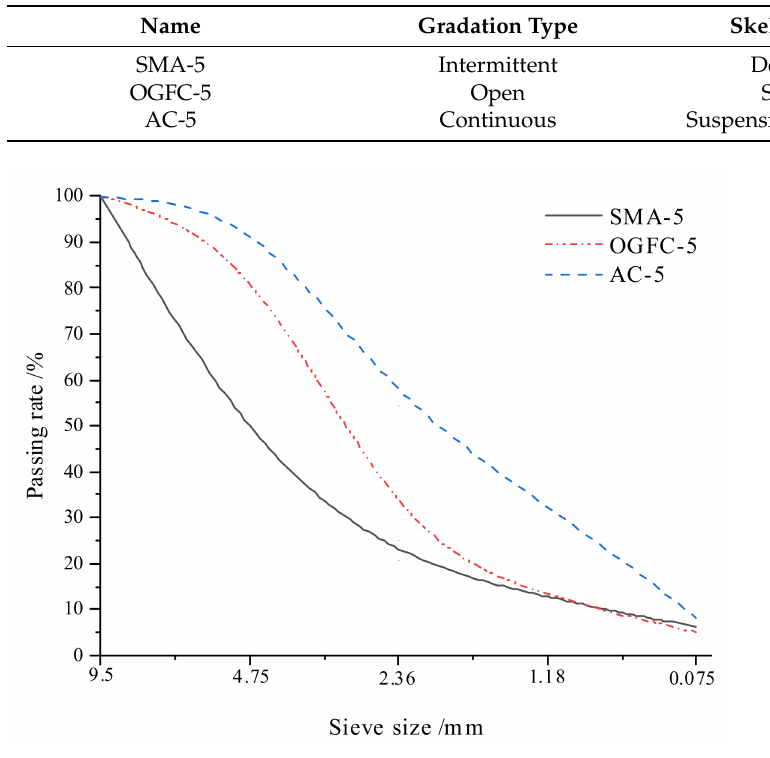
Figure 2. Gradation compositions of SMA-5, OGFC-5, and